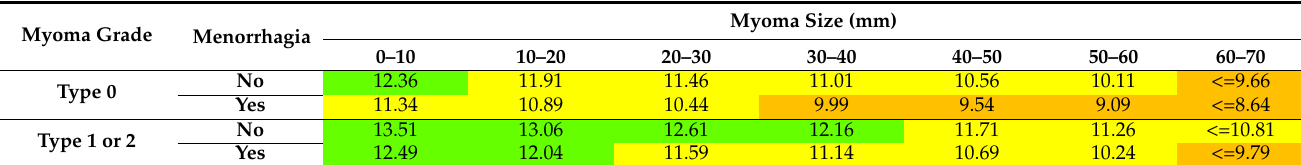
Table 7. Interaction among hemoglobin level, myoma grade, myoma size, and